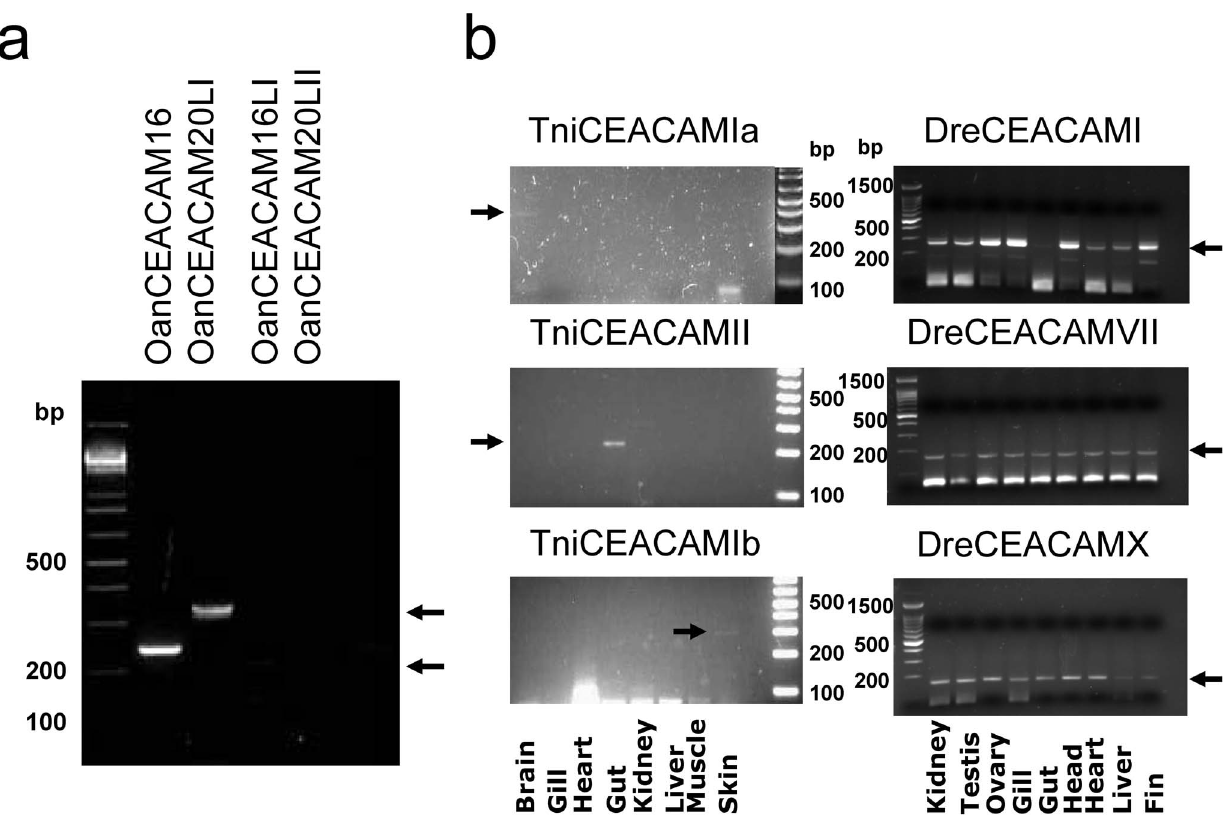
Figure 4. Analysis of CEACAM transcript expression in tissues of platypus, pufferfish T.nigroviridis, and zebrafish D.rerio . a) RT-PCR analysis of OanCEACAM16, 16LI, 20LI, and 20LII in the intestine of a platypus. Size markers are shown on the left. Specific PCR products for OanCEACAM16 and 20LI are indicated by arrows. b) RT-PCR detection of transcripts of DreCEACAMI, VII, and X in kidney, testis, ovary, gill, gut, head, heart, liver, and fin of D. rerio (right panel) as well as TniCEACAMI-III in brain, muscle, gut, kidney, heart, liver, gill, and skin of T. nigroviridis (left panel) using gene-specific primers (Table S4 in File S1). Expected size of PCR products for each gene is indicated by an arrow.